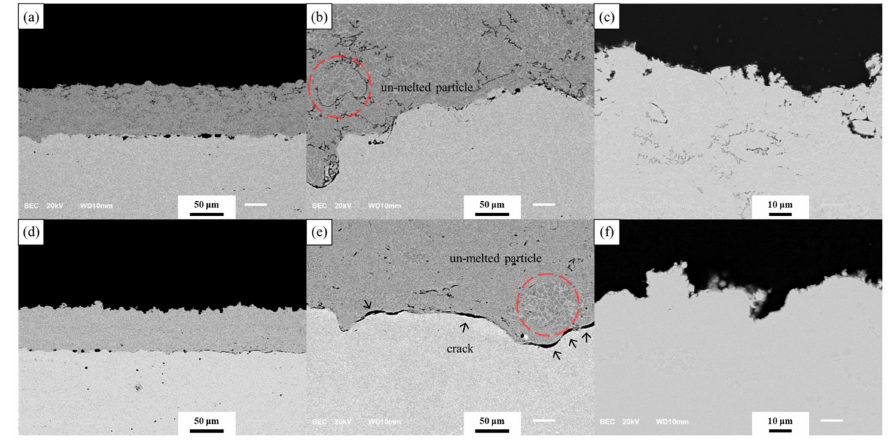
Figure 4. Microstructural analysis after JETS test for HVOF ( a – c ) and VPS ( d – f ) coated